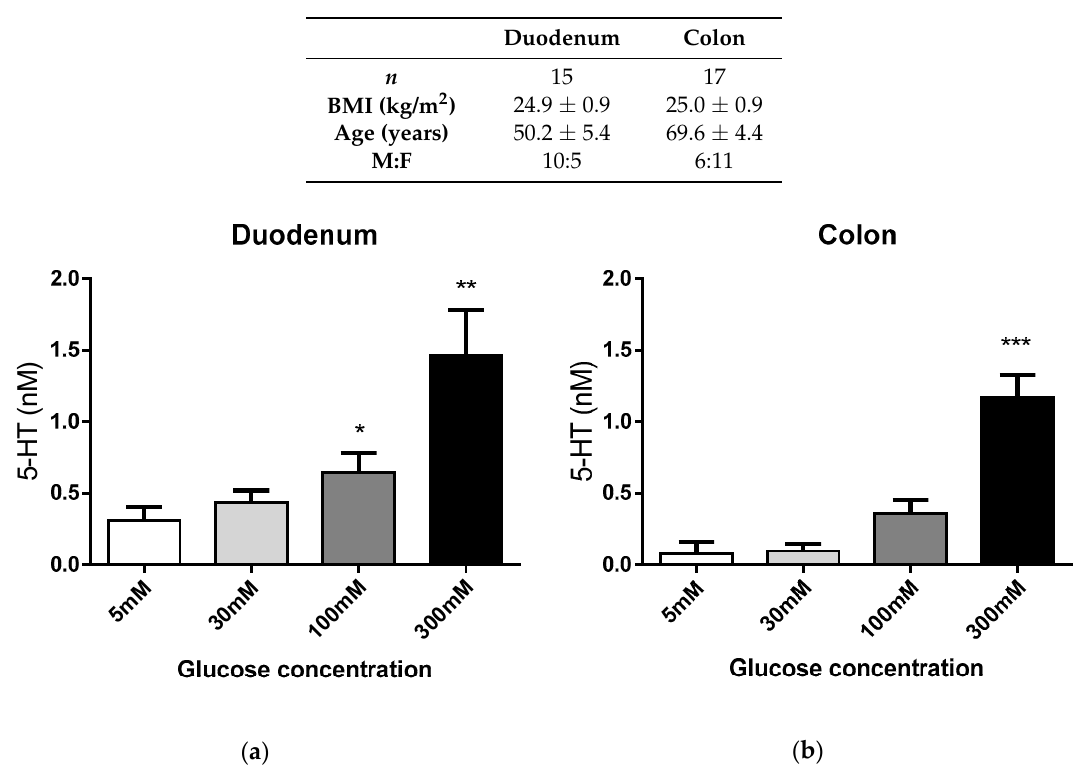
Table 1. Demographics for glucose dose response in non-obese individuals for data shown in Figure 1.